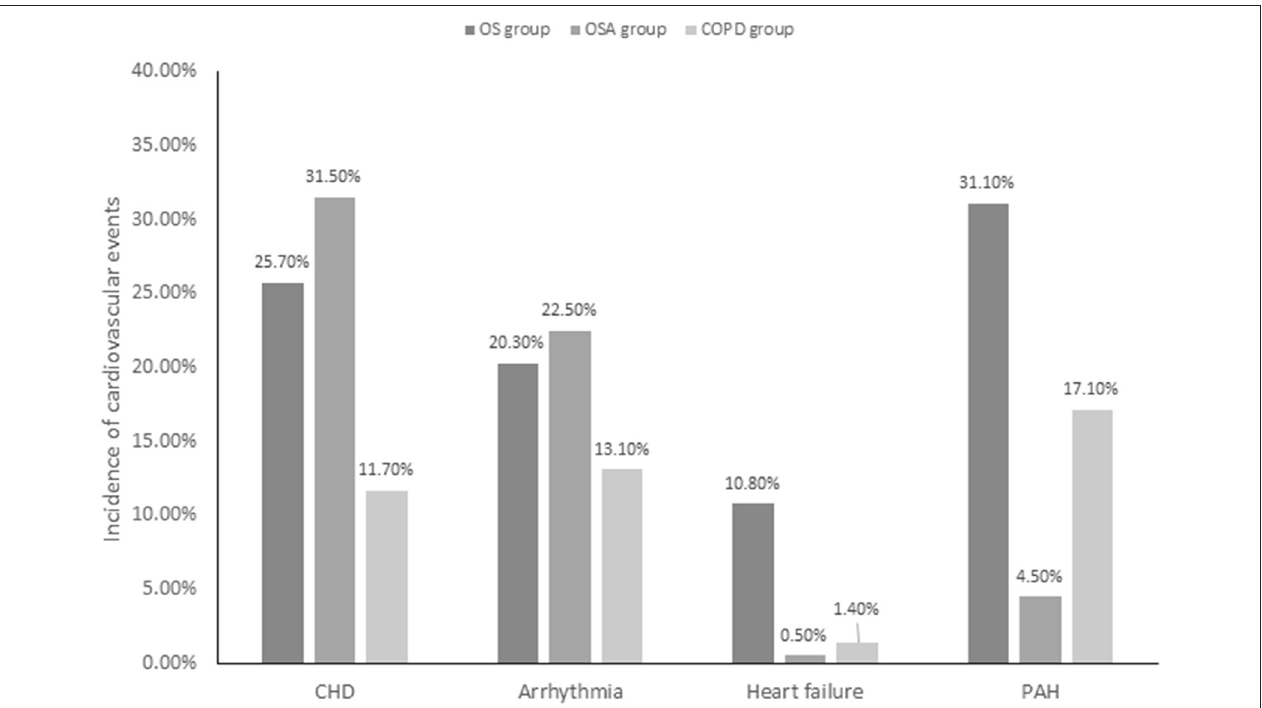
FIGURE 2 | Incidence of cardiovascular events in study patients. OS, overlap syndrome; OSA, obstructive sleep apnea; COPD, chronic obstructive pulmonary disease; CHD, coronary heart disease; PAH, pulmonary arterial hypertension; PTE, pulmonary embolism.